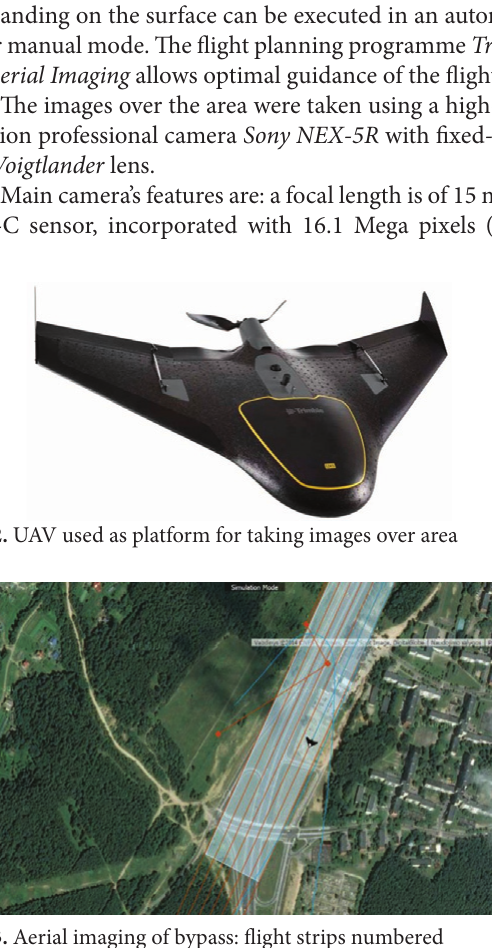
Fig. 3. Aerial imaging of bypass: flight strips numbered from 1 to 7